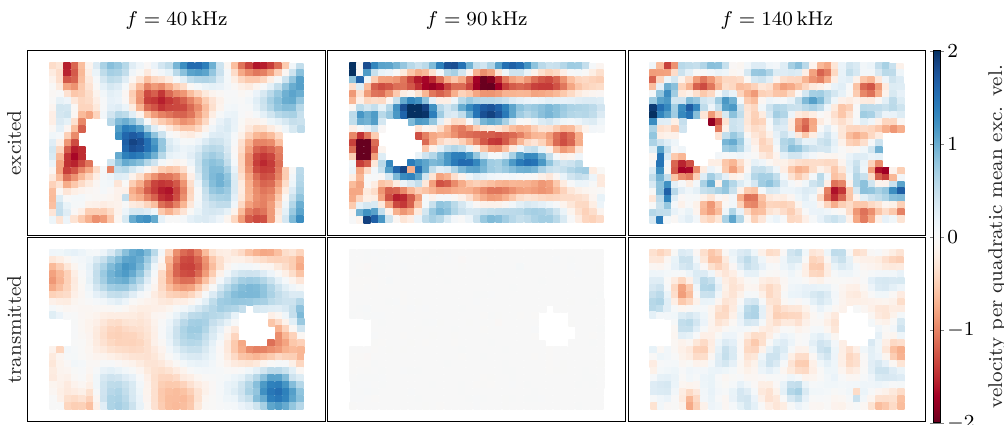
Figure 8. Normal velocity fields scanned by the LDV: The top row shows the exciting piezoelectric element at the frequencies marked in Figure 9; the bottom row displays the corresponding transmitted fields. The band gap at 90kHz is clearly